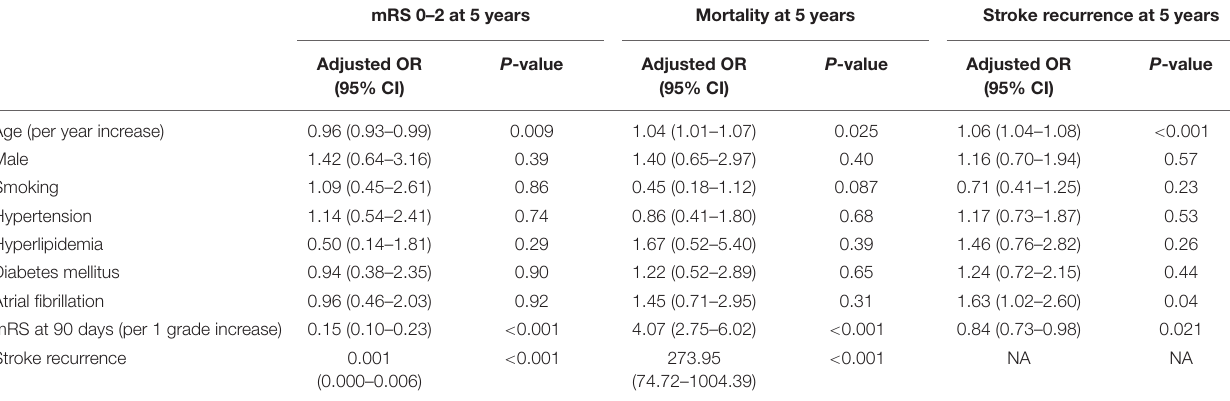
TABLE 2 | Multivariable analysis: predictors of functional outcomes at 5 years follow